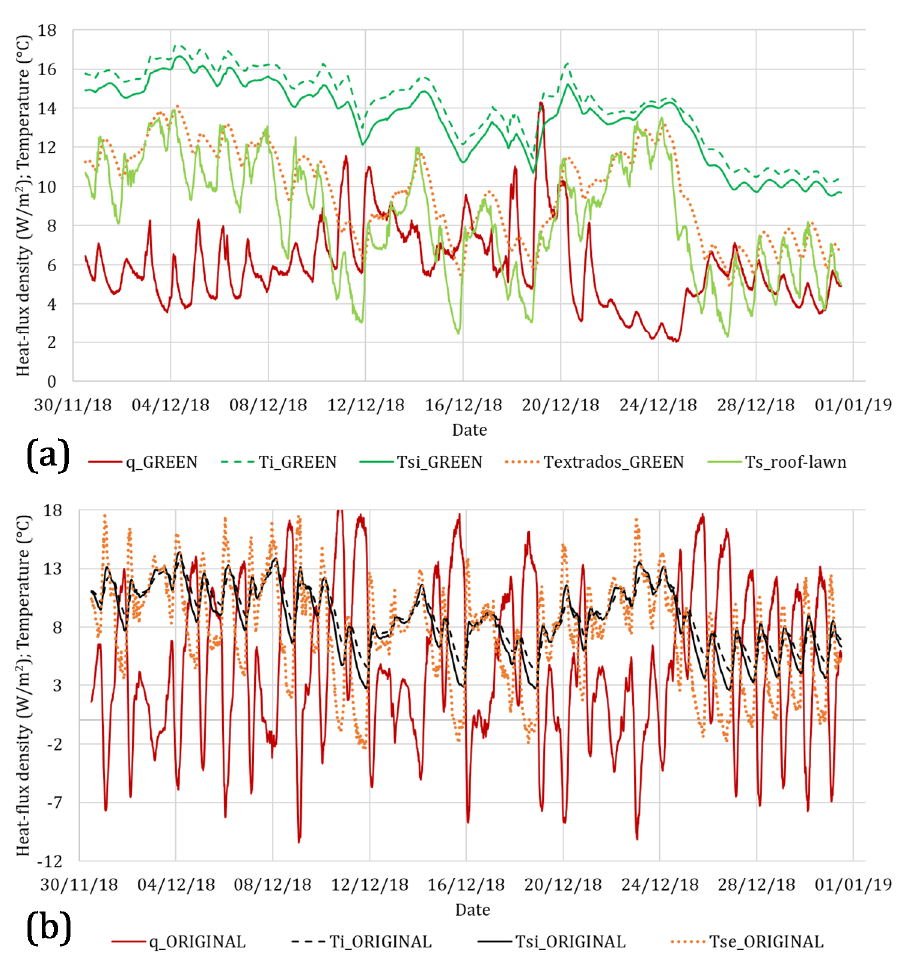
Figure 5. Heat fluxes, indoor temperatures and internal surface temperatures registered during winter for the green roof ( a ) and the original one ( b ).